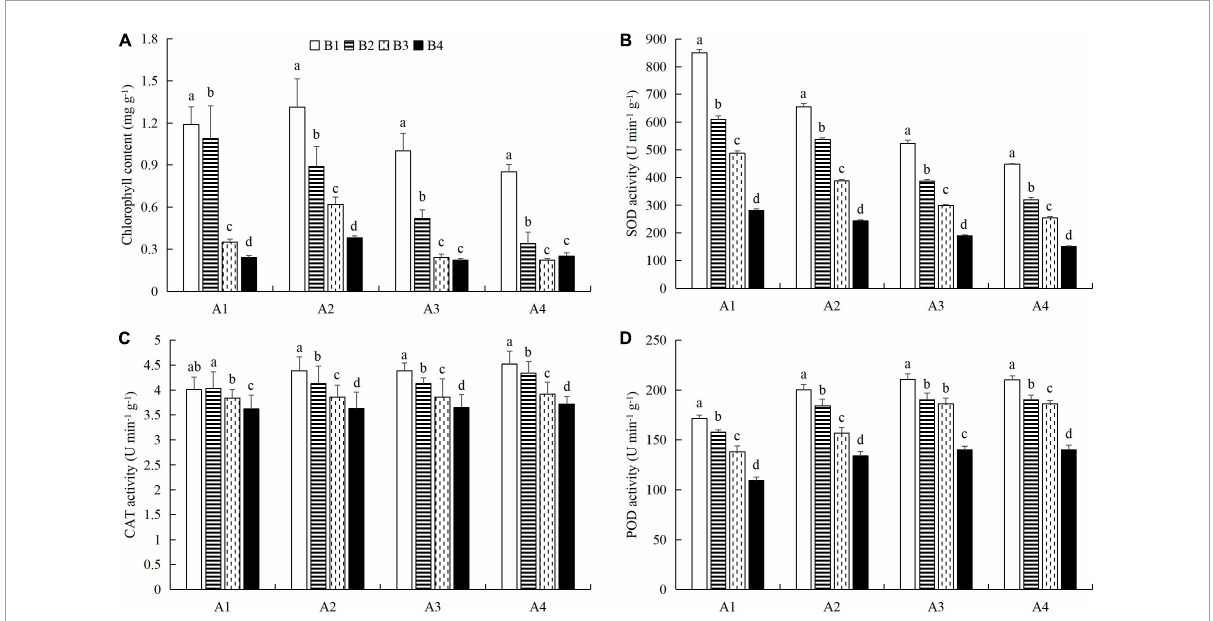
FIGURE9 The effects of imidacloprid on (A) chlorophyll content and the activities of (B) superoxide dismutase (SOD), (C) catalase (CAT), and (D) peroxidase (POD) in cucumber leaves at four azoxystrobin concentrations. Azoxystrobin concentrations: 4 mg L − 1 (A1), 2 mg L − 1 (A2), 1 mg L − 1 (A3), and 0 mg L − 1 (A4). Imidacloprid concentrations: 750 mg L − 1 (B1), 500 mg L − 1 (B2), 250 mg L − 1 (B3), and 0 mg L − 1 (A4). The mean value ± p < 0.05 error bar data were presented in the figure and different alphabetical letters indicate the significant differences between the different imidacloprid concentrations.